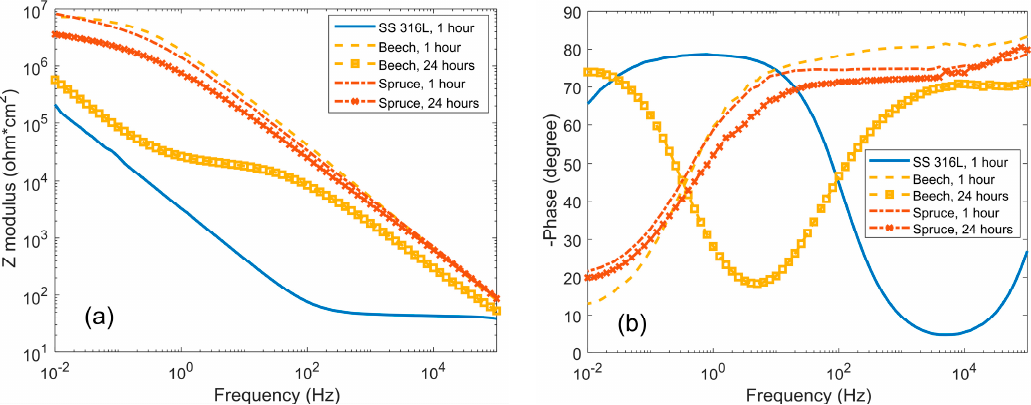
Figure 8. Bode plots of samples obtained from electrochemical impedance spectroscopy (EIS) measurements during 24 h immersion in PBS solution: ( a ) impedance modulus vs frequency, ( b ) phase angle vs frequency.